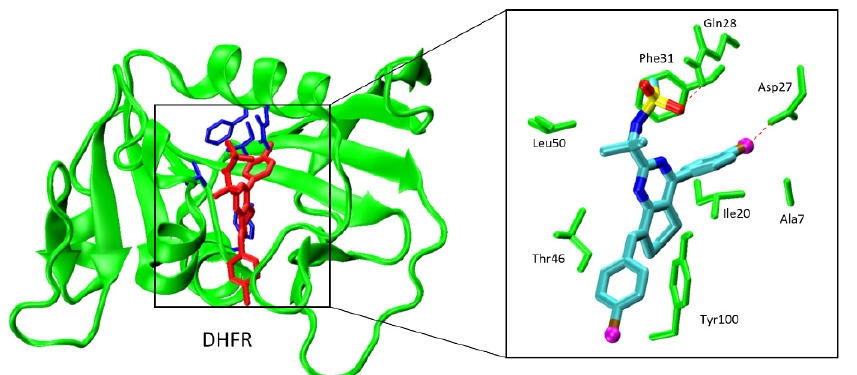
Figure 1. The best-scored docked pose of 3c bound to the Mycobacterium tuberculosis DHFR protein (PDB code 1DF7). Ribbon representation of the structure of the DHFR- 3c complex. The protein is shown as a ribbon model in green and 3c is represented as a licorice model in red. The active site residues of DHFR, such as Ile5, Gln28, Phe31, Ile94, and Tyr100, are shown in blue. (Insert Panel) A scheme of protein–ligand interactions of 3c with neighboring residues, colored green. The red dotted lines show key short-range interactions between ligand 3c and the DHFR enzyme.